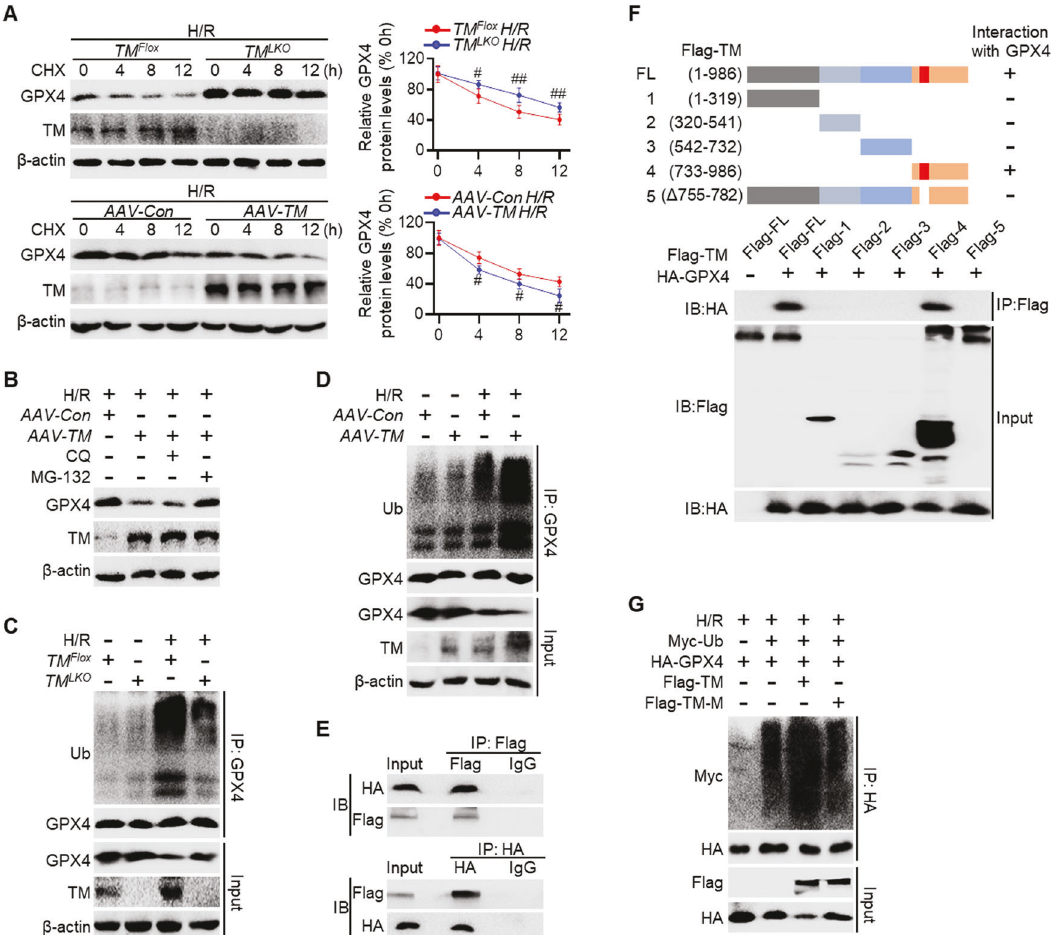
Fig. 6 TMEM16A directly binds with GPX4 and facilitates its ubiquitination. A Western blotting results of GPX4 protein expression in hepatocytes treated with 4 h of hypoxia and 12 h of reoxygenation, followed by incubation with cycloheximide (CHX, 100 µg/mL) for the indicated durations ( n = 6). # P < 0.05, ## P < 0.01 versus TM Flox H/R or AAV-Con H/R. B GPX4 protein expression in hepatocytes isolated from AAV-TM -treated mice after 4 h of hypoxia and 12 h of reoxygenation, followed by treatment with MG-132 (10µmol/L) or chloroquine (CQ, 20 µmol/L) for 4 h ( n = 6). GPX4 protein expression in hepatocytes isolated from C TM LKO and D AAV-TM -treated mice and their control littermates after 4 h of hypoxia and 12 h of reoxygenation (n = 4). Immunoprecipitation was performed with an anti-GPX4 antibody followed by western blot analysis of GPX4 ubiquitination. E Flag and HA expression in HEK293T cells co-transfected with vectors expressing Flag-TMEM16A and HA-GPX4 (n = 6). Immunoprecipitation (IP) was performed with an anti-Flag antibody (upper panel) or anti-HA antibody (lower panel), followed by western blotting GPX4, in combination with Myc-Ubiquitin, Flag-TMEM16A, and Flag-TM-M, followed by H/R treatment ( n = 4). Data were presented as the mean ±